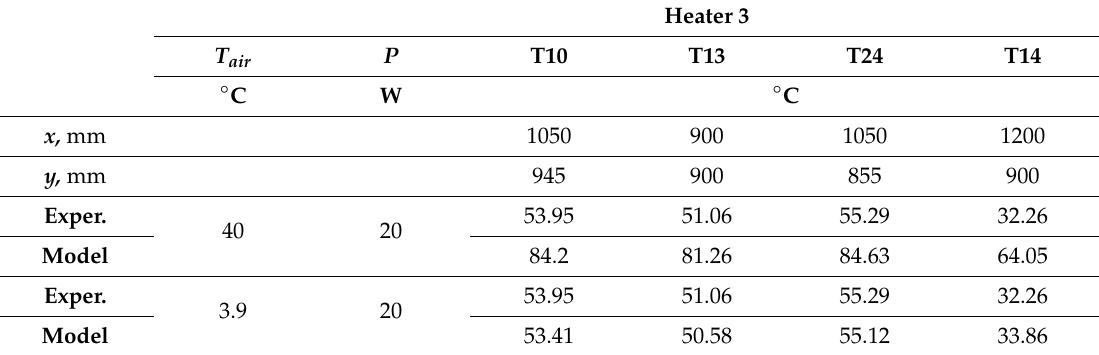
x, mm y, mm Exper. Model Exper Model Table 3. Temperature values obtained from tests and simulations (temperature values around heater 3).